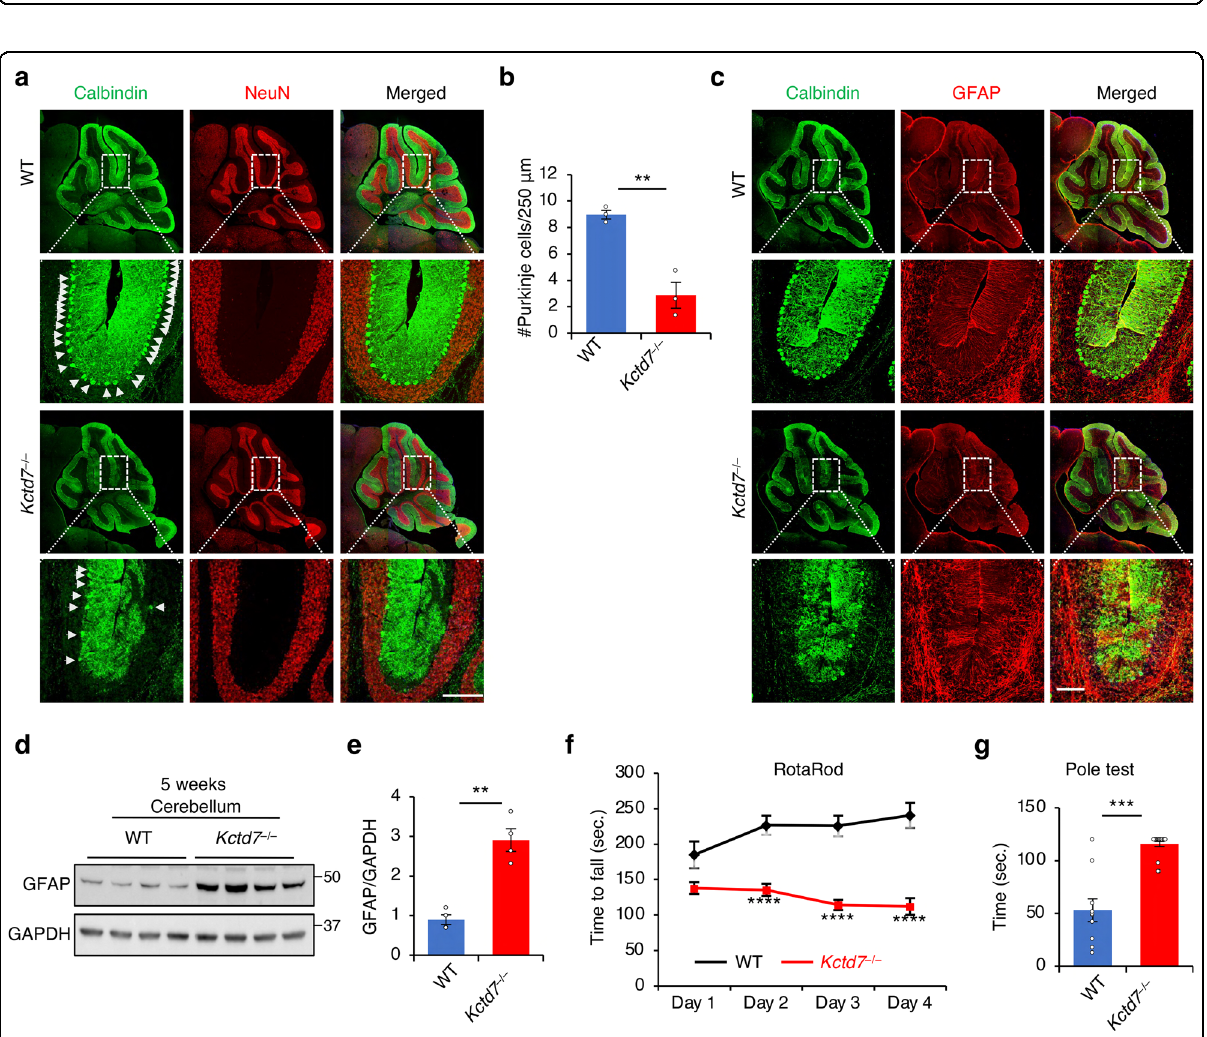
Fig. 7 KCTD7 de fi ciency leads to behavioral impairment and neurodegeneration. a – c Confocal microscopy analysis of the cerebellum from 5- week-old WT and Kctd7 – / – mice. α -calbindin antibody and α -GFAP antibody were used to label Purkinje cells ( a ) and astrocytes ( c ), respectively. Quanti fi cation of Purkinje cell numbers is reported in b , n = 5 per genotype. Scale bars, 200 μ m. d , e Immunoblot analysis of cerebellar tissue from 5- week-old WT and Kctd7 – / – mice using α -GFAP antibody. f Rotarod test measuring the latency to fall for 8-week-old WT ( n = 10) and Kctd7 – / – ( n = 16) mice. g Inverted pole test measuring the time used to climb down from the pole for 8-week-old WT ( n = 10) and Kctd7 – / – ( n = 19) mice. Data represent means ± SEM; ∗ P < 0.05, ∗∗ P < 0.01, ∗∗∗ P < 0.001, ns not signi fi